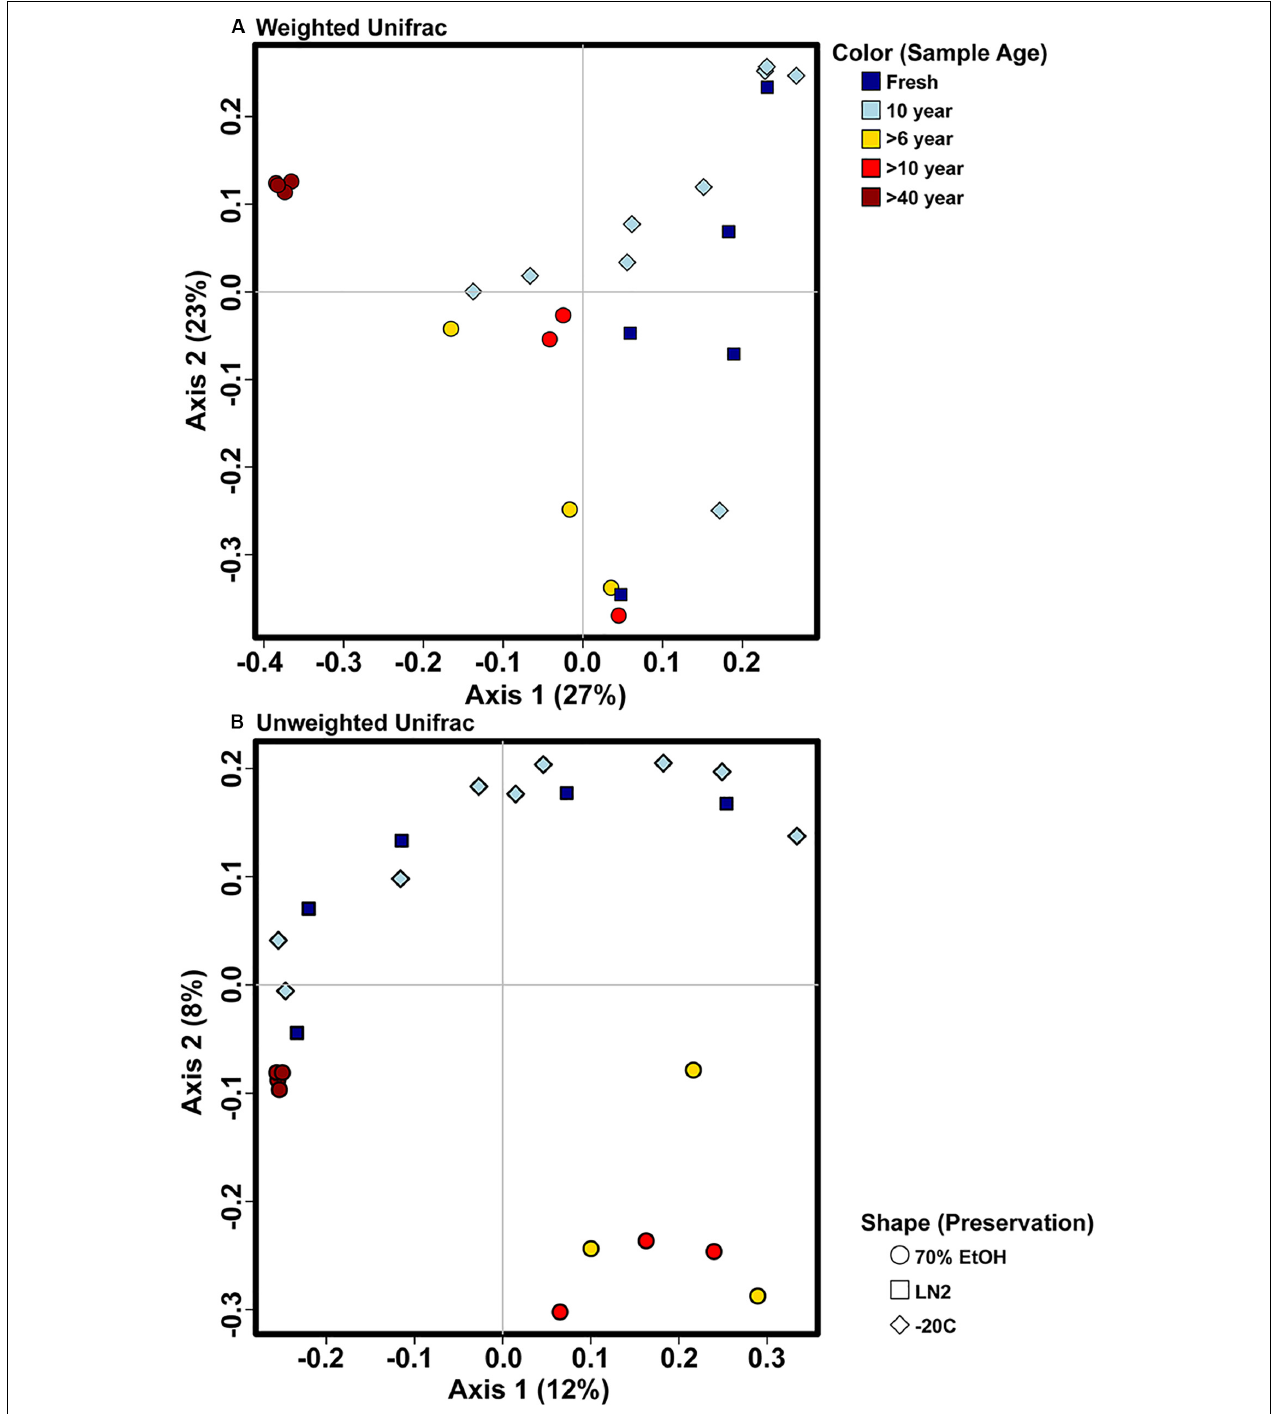
FIGURE 5 | Principal coordinate analysis plots of OTU based (A) weighted and (B) unweighted Unifrac distances depicting bacterial beta diversity of intestinal samples of varying age and preservation. Color indicates the sample age, while shape indicates the preservation type.